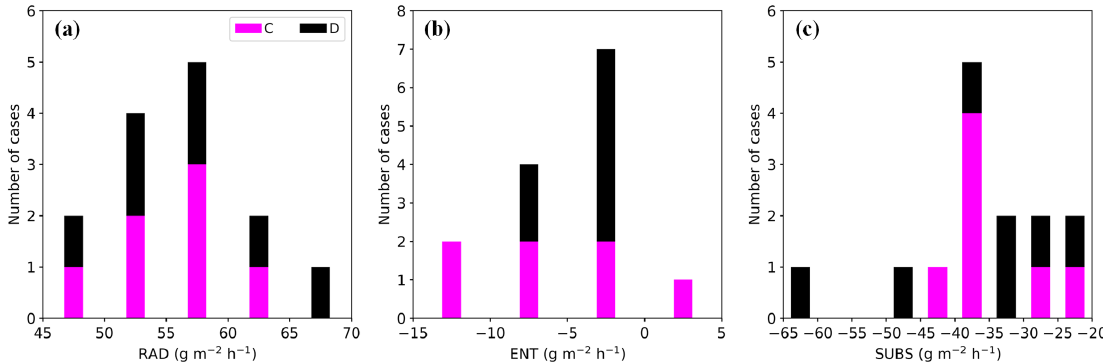
Figure 9. Distributions of radiative (RAD; a ), entrainment (ENT; b ) and large-scale subsidence (SUBS; c ) LWP budget terms (Eq. 1) derived from the 14 05:00UTC standard soundings at the Savè supersite for which the probe crossed into the LLSC layer (Fig. 8 and Table A1). The methodology is described in Sect.